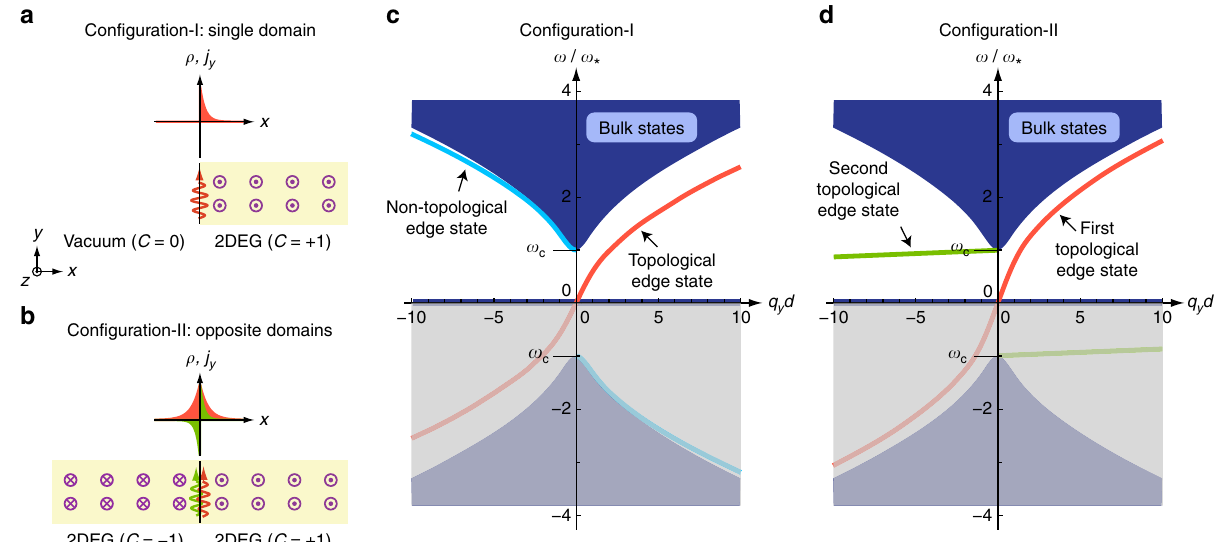
Figure 2 | Schematics of the system configurations and numerically calculated bulk and edge spectra. ( a ) Configuration-I: A 2DEG is in contact with vacuum under a uniform magnetic field along the positive z direction. ( b ) Configuration-II: A 2DEG is uniformly filled in the whole space but two opposite magnetic fields are applied along the positive and negative z direction. The edge state profiles of density and current components are shown as well. For Configuration-II, the two edge states have opposite symmetries. ( c ) The spectra corresponding to Configuration-I. ( d ) The spectra corresponding to Configuration-II. The negative-frequency part reflects the redundant degrees of freedom of the real-valued classical field and so is